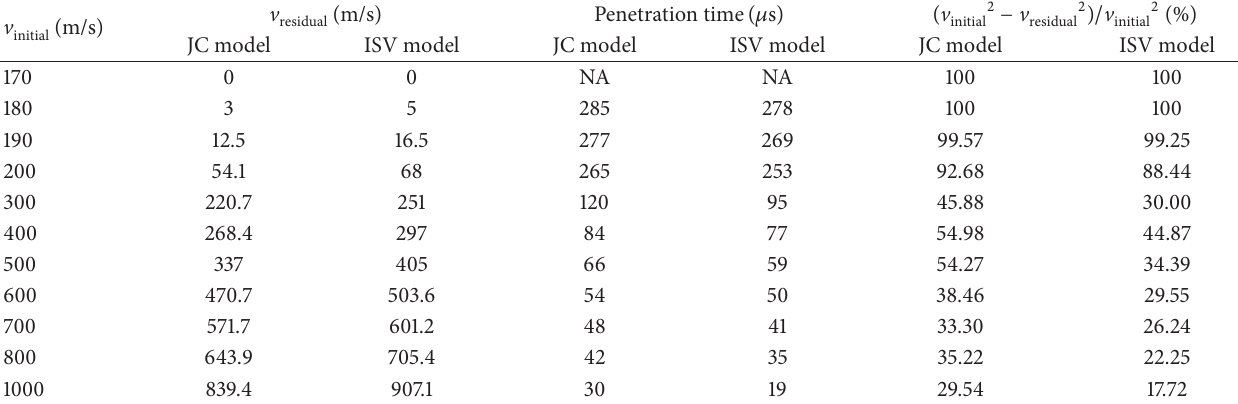
Figure 4: Penetration simulation yielded from JC model, V initial = 200 m/s at 𝑡 = 0 (a), 50 𝜇 s (b), 100 𝜇 s (c), 150 𝜇 s (d), and 265 𝜇 s (e). Table 3: Initial velocities and residual velocities yielded from JC model and the ISV damage